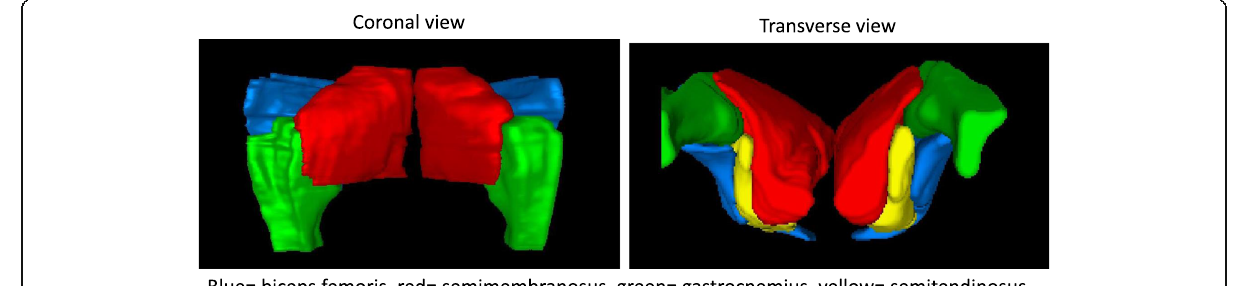
Fig. 1 Coronal and transverse 3D rendering of the volumetric pig hindlimb muscles from the CT images used to identify muscle boundaries to measure 201 Tl uptake for each muscle. Color code explained below